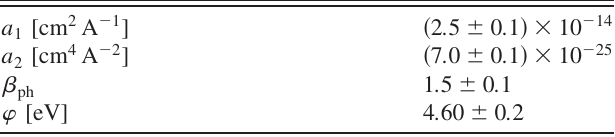
TABLE I. In this table are reported the parameters used to simulate both the phase scan and emission curves.